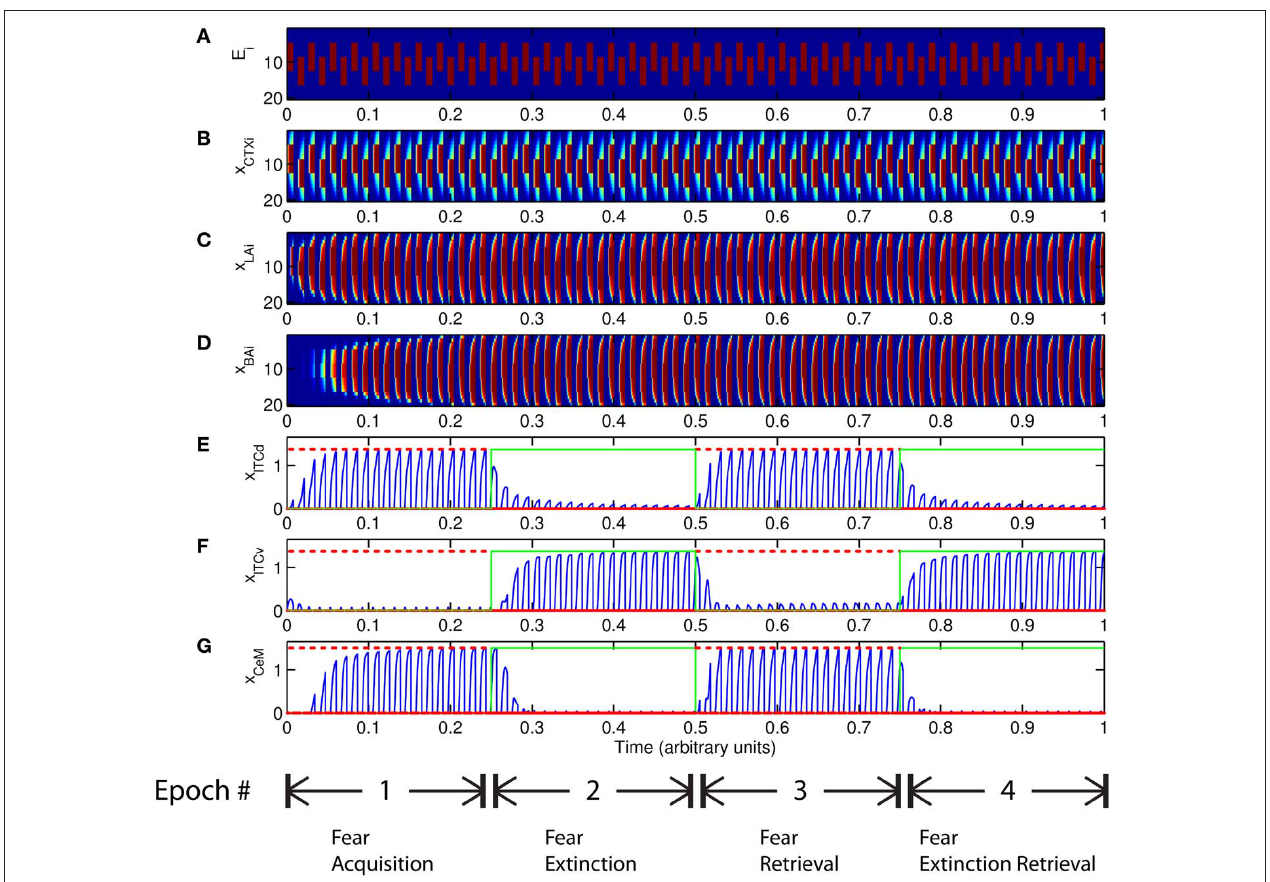
FIGURE 10 | Time evolution of model cell activities during “generalization” mode. Both CS signals are extinguished. Plots show the time evolution of model cell activities during four consecutive epochs. Each plot (A–D) shows the temporal evolution of an array of 20 cells, with the y-axis representing the cell index, and the color representing strength of activation (Blue is low, red is high). Each plot